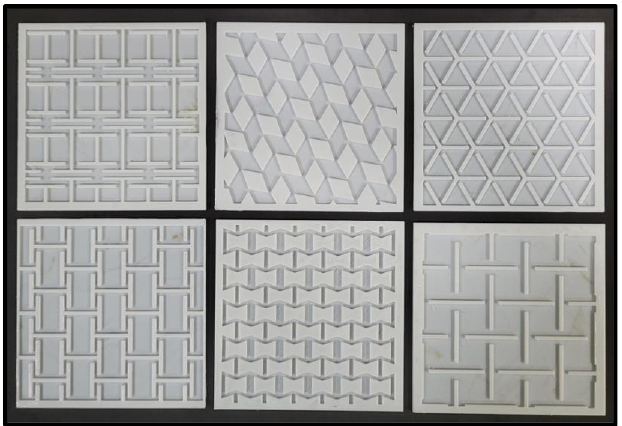
Figure 1. Three-dimensionally printed casting molds of skin graft models.